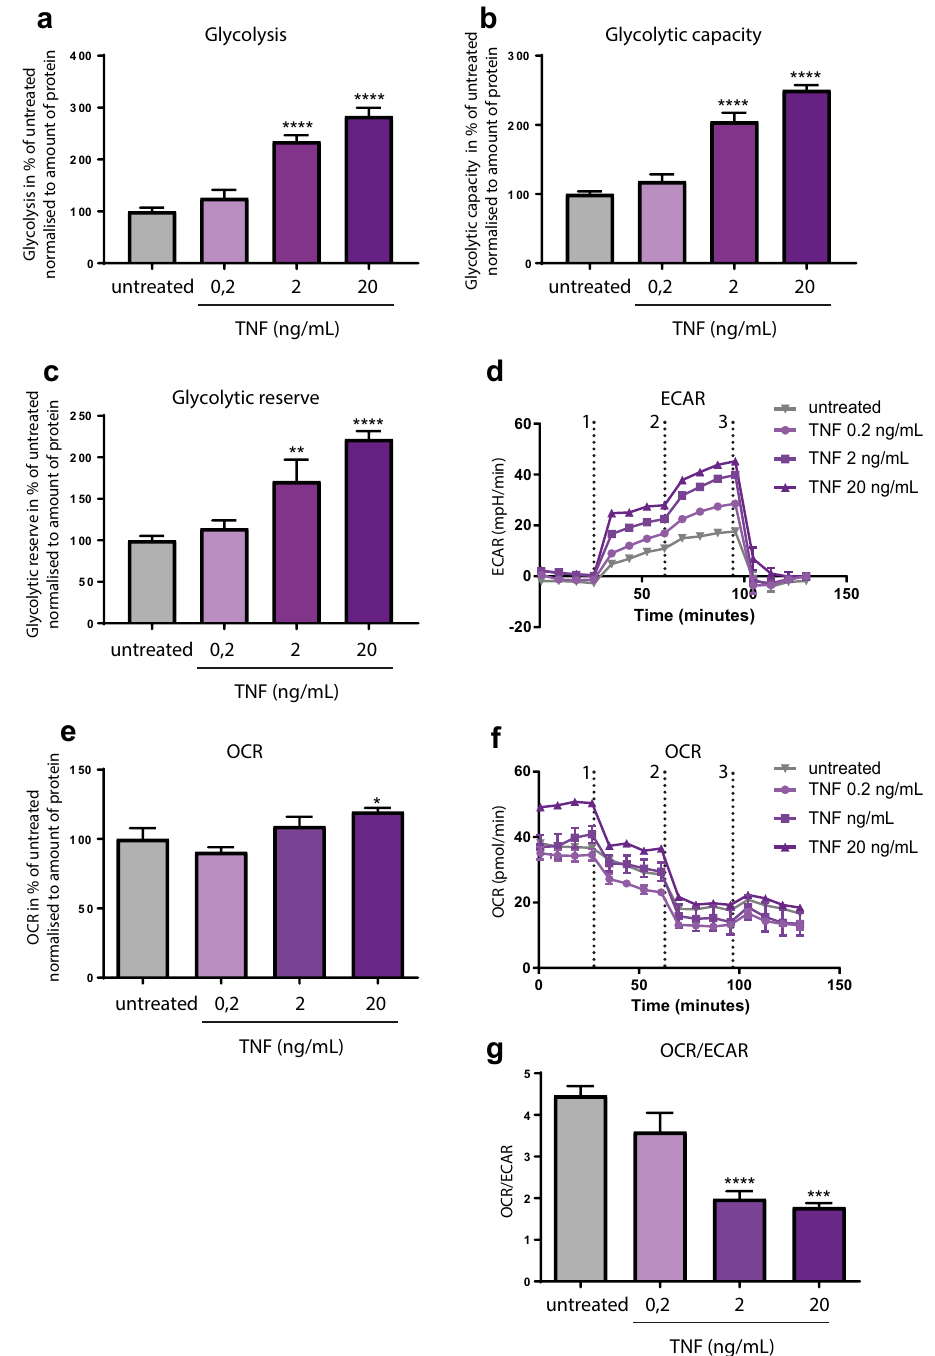
Figure 1. TNF activates glycolysis and mitochondrial respiration in H-FLS. Real-time analysis of glycolytic function in FLS from three healthy donors after 24 h incubation with recombinant human TNF using Seahorse XFe96. Glycolysis stress test with injection of glucose (24 mM), oligomycin (1 µM) and 2-DG (100 mM). ( a ) Glycolysis, ( b ) Glycolytic capacity, ( c ) Glycolytic reserve, ( d ) Representative Seahorse ECAR graph from one experiment. 1—injection of 24 mM glucose, 2—1 µM Oligomycin and 3—100 mM 2-deoxyglucose. ( e ) OCR, ( f ) Representative Seahorse OCR graph from one experiment. 1—injection of 24 mM glucose, 2—1 µM Oligomycin and 3—100 mM 2-deoxyglucose. ( g ) OCR/ECAR after glucose injection (experiments performed with 3–6 technical replicates, 2 independent experiments, 3 different donors). Data were normalized to protein content using BCA assay. Values represent means ± SEM. *P ≤ 0.05; *P ≤ 0.01; ***P ˂ 0.001; ****P ˂ 0.0001, unpaired one-way Anova with Dunnett